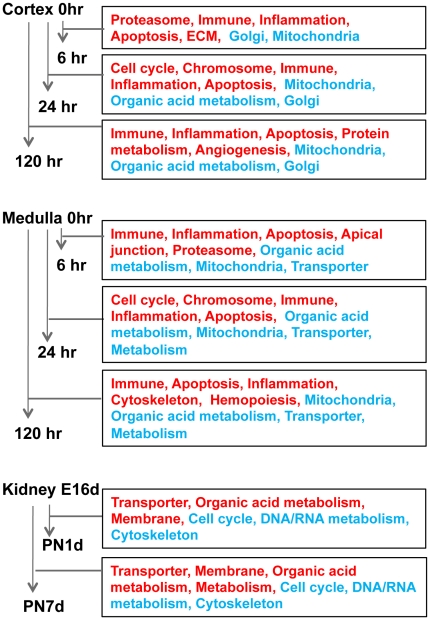
Pathway analysis of expression changes associated with kidney regeneration after ischemic injury and development.Pathway analysis shows the significantly up- and down-regulated GO functional categories (red- and blue-coded in the corresponding rectangles, respectively) in each time point measured after ischemic induction (cortex and medulla of rat kidney) or in the corresponding developmental time points (mouse kidney). Only representational functional categories are shown from a list of significantly enriched GO categories. Full list of observed GO categories are available in Tables S1,S2,S3.